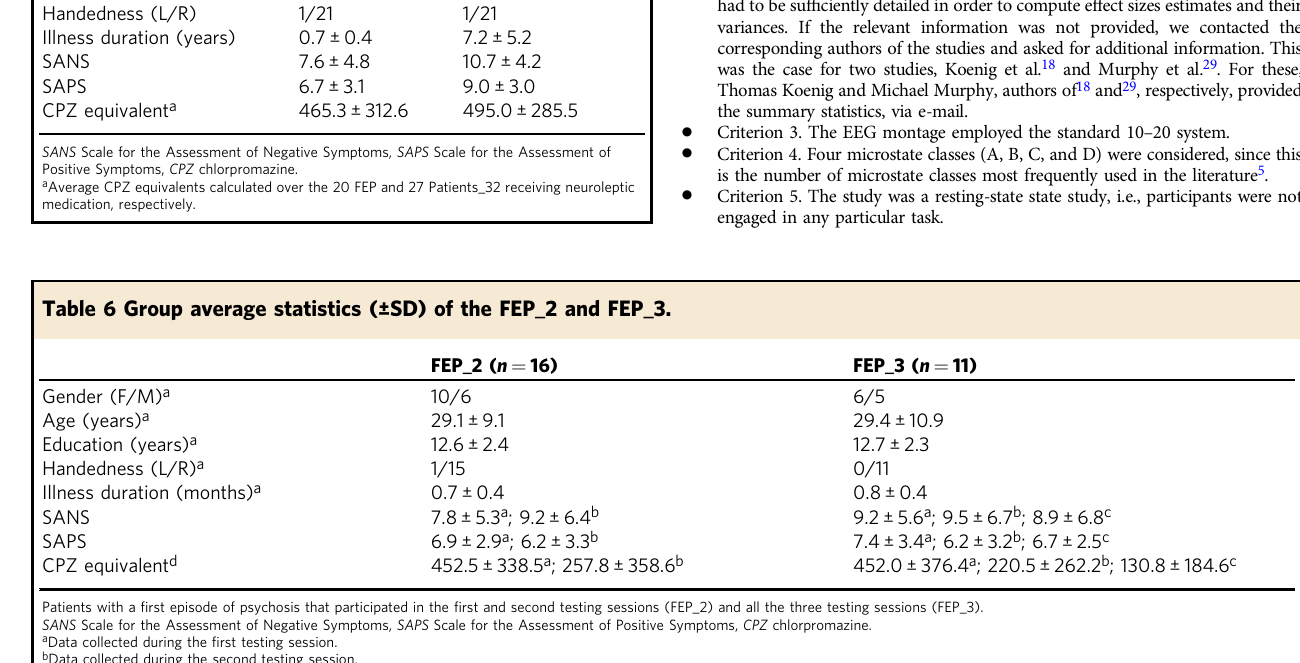
Patients with a fi rst episode of psychosis that participated in the fi rst and second testing sessions (FEP_2) and all the three testing sessions (FEP_3). SANS Scale for the Assessment of Negative Symptoms, SAPS Scale for the Assessment of Positive Symptoms, CPZ chlorpromazine. a Data collected during the fi rst testing session. b Data collected during the second testing session. c Data collected during the third testing session. d Average CPZ equivalents calculated over 16 and 11 patients in FEP_2 and FEP_3, respectively, by assigning a value of 0 to participants off neuroleptic